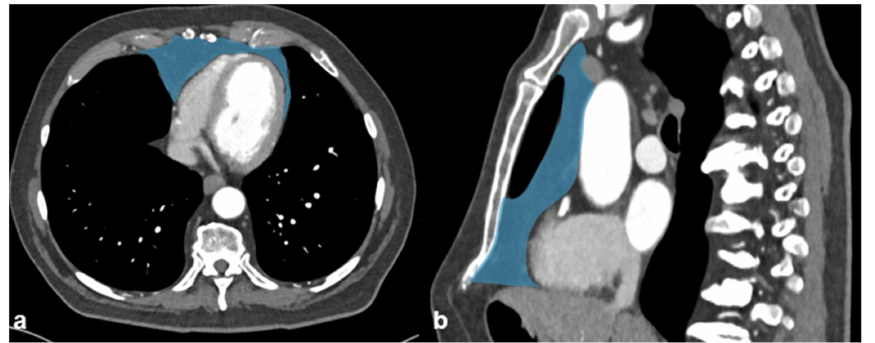
Figure 2. Morphometric measurements of anterior mediastinal fat on ( a ) axial and ( b ) sagittal reformations.